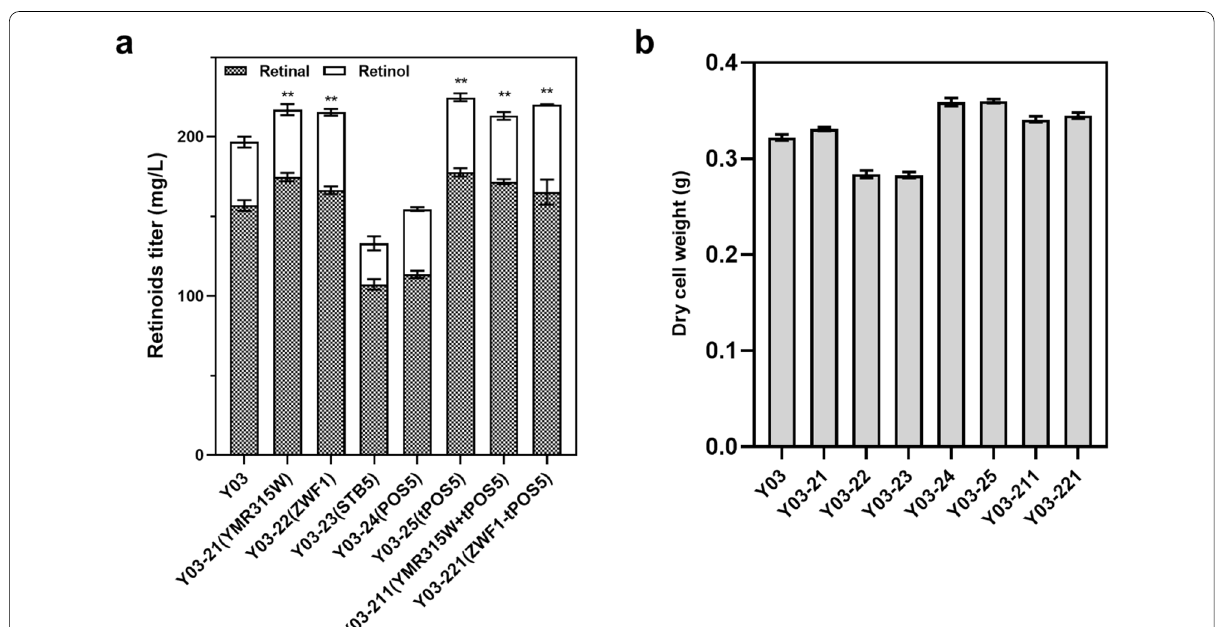
Fig. 4 Effect of enhancing NADPH supply on retinoids production. a Retinoids titer and b dry cell weight of each strain are indicated. The error bars represent standard deviations calculated from triplicate experiments, and statistical significance of the different retinoids levels in comparison with the control was evaluated using Student’s t test (*, P < 0.05; **, P < 0.01)